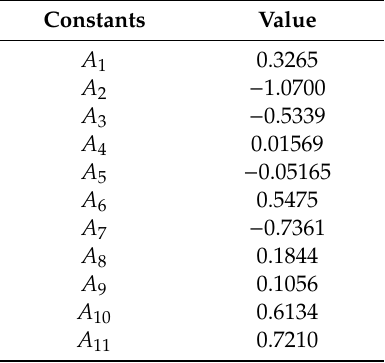
Table A1. Values of the